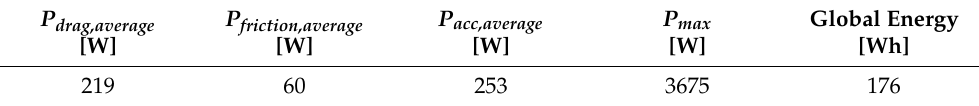
Table 2. Power and energy requirements of the tested motorcycle during the UDC driving cycle.